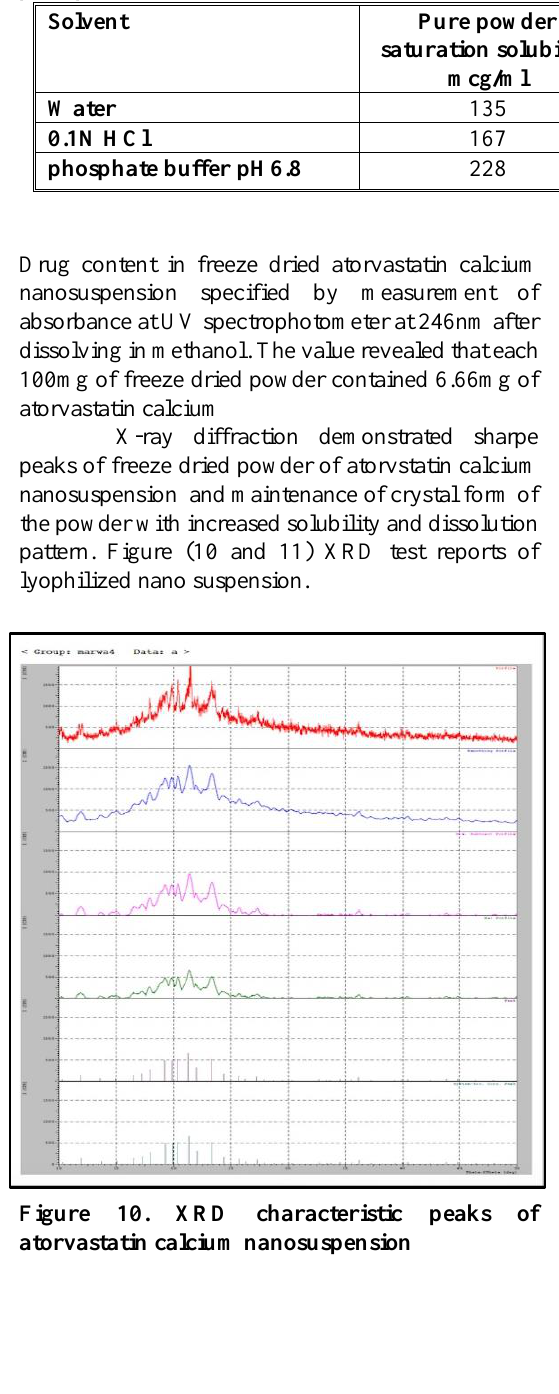
Table 4. Saturation solubility of freeze dried nanosuspension F18 atorvastatin calcium in comparison with pure powder.